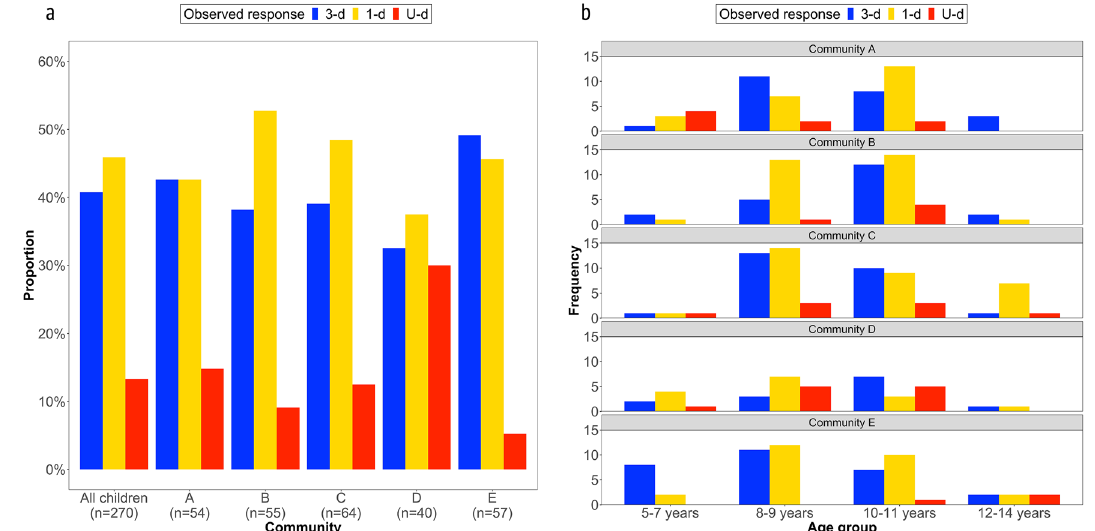
Figure 2. Descriptive distribution of observed responses. Children chose a demonstrated option more frequently than an undemonstrated option across communities, with little variation by age across communities. Panel ( a ) shows response distributions following the 3-d option (blue), 1-d option (yellow) and U-d option (red) across the five communities. Panel ( b ) shows the frequencies of each observed response by community and age